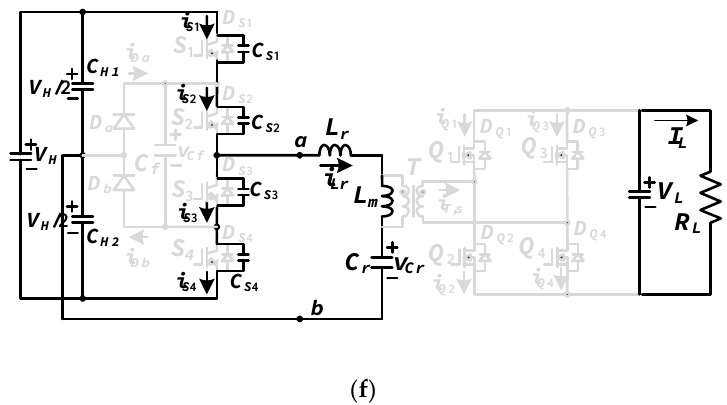
Figure 3. The corresponding equivalent circuits related to six operating steps for forward power operation ( a ) step 1 circuit ( b ) step 2 circuit ( c ) step 3 circuit ( d ) step 4 circuit ( e ) step 5 circuit ( f ) step 6 circuit.